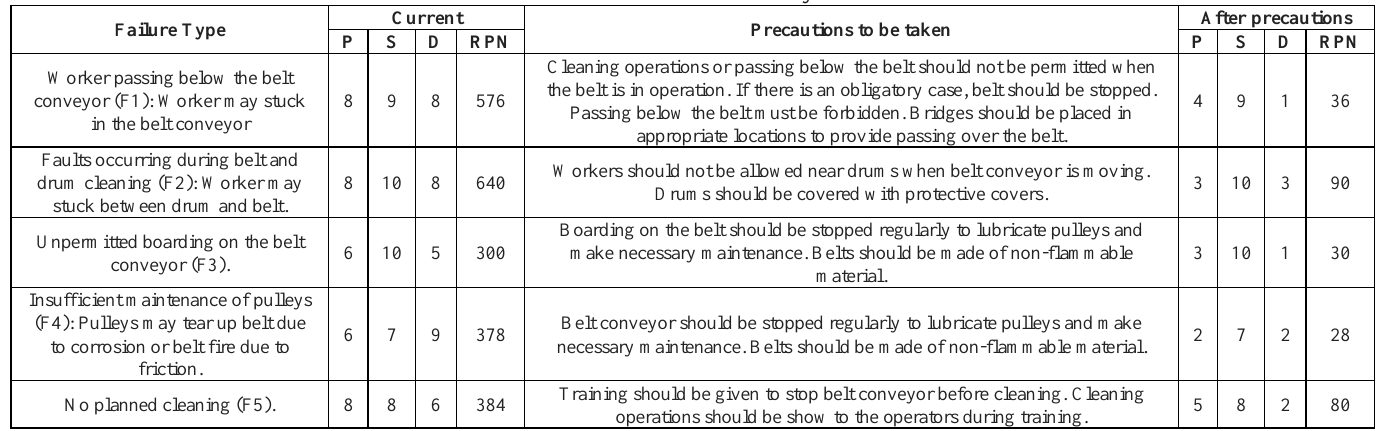
Table 1: FMEA table for belt conveyor accidents.